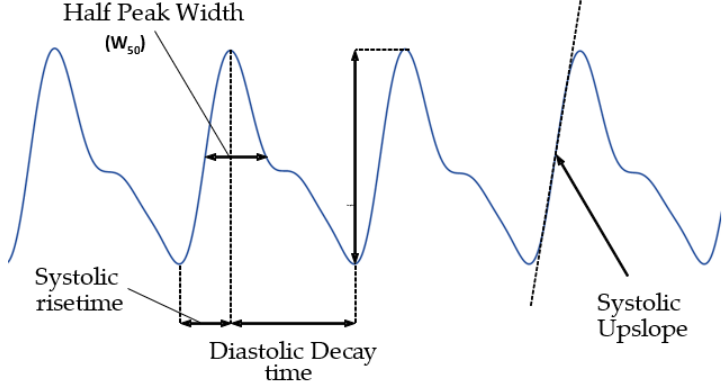
Figure 4. PPG signals and features extracted.